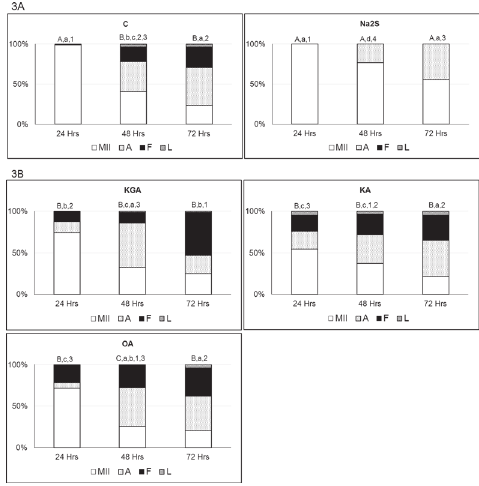
Figure 3. Effects of an elevated H 2 S level and inhibition of H 2 S producing enzymes during oocyte aging. Oocytes were cultivated to metaphase II and then exposed to prolonged cultivation in a modified M199 medium for 24, 48 and 72 hours in the presence of a H 2 S donor or H 2 S producing enzymes inhibitors. 3A . Na 2 S (Na 2 S.9H 2 O; 300 μ M) was used as the H 2 S donor. 3B . Oxamic acid (1mM, OA) was used as a CBS inhibitor, beta-kyano-L-alanine (1mM, KA) was used as a CSE inhibitor and alpha-ketoglutaric acid disodium salt dihydrate (5mM, KGA) was used as a MPST inhibitor. C- control; Na 2 S (300 μ M, Na 2 S.9H 2 O); KGA — alpha-ketoglutaric acid disodium salt dihydrate (5 mM); KA – beta-kyano-L-alanine (1mM); OA — oxamic acid (1 mM); MII — intact oocytes (oocytes at metaphase II, anaphase II or telophase II), A — activated oocytes (oocytes with pronuclei or embryos), F — fragmented oocytes, L — lysed oocytes. Different letters and numbers indicate significant differences between different treatments and hours of aging (P < 0.05). A,B,C – statistically significant differences in portion of MII stage oocytes between individual treatments. a,b,c,d – statistically significant differences in portion of activated oocytes between individual treatments. 1,2,3 – statistically significant differences in portion of fragmented oocytes between individual treatments .